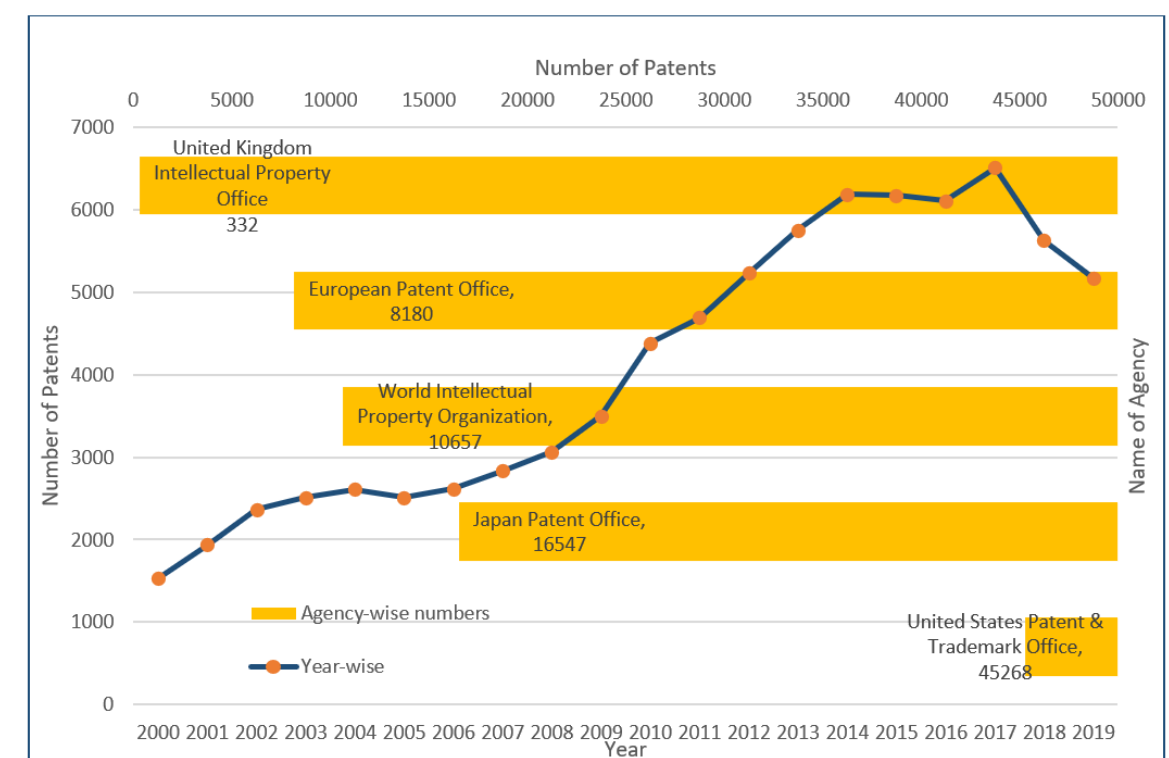
Figure 1. Number of patents registered in different agencies and the number of total patents in the duration of 2000–2019 (Results were obtained from the Scopus database using the keyword “lignin”).